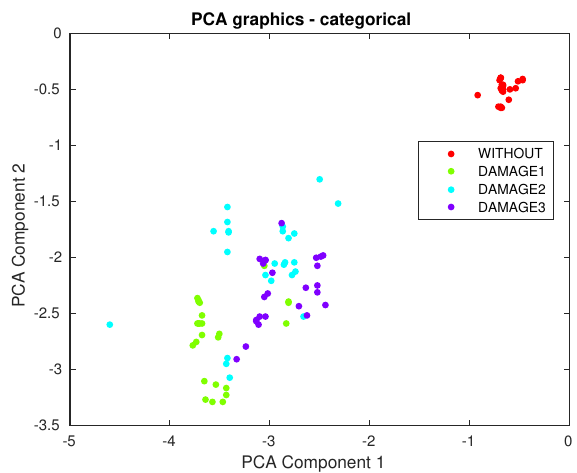
Figure 28. First principal component versus second principal component in the aluminum plate described in Section 4.2.